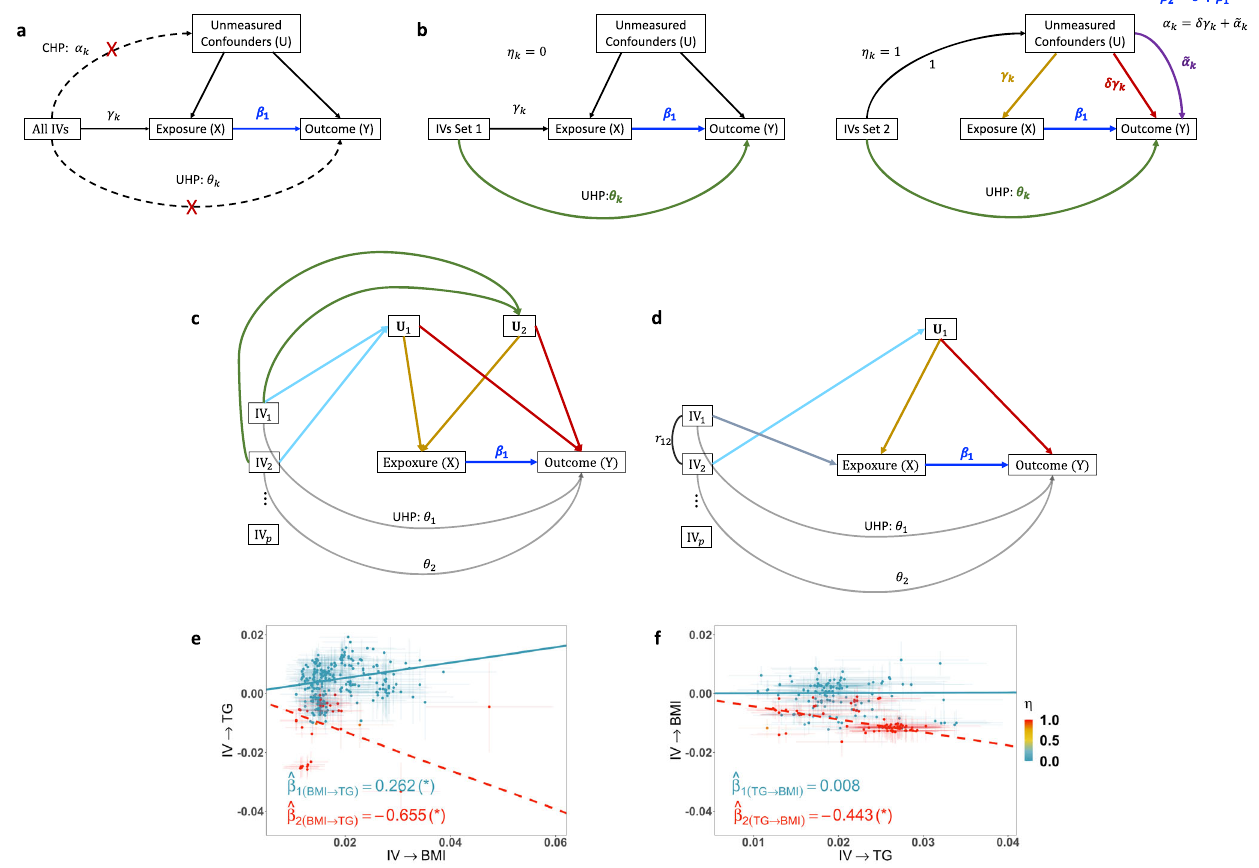
Fig. 1 | Causal diagrams of classic MR and MR-CUE models, with an illustrative example. a The causal diagram of classic MR models. Classic MR models assume that IVs affect outcome through only exposure. b An illustration of the MR-CUE model. MR-CUE decomposes IVs into two sets, those not affected by CHP (left, η η k =0) and those affected by CHP (right, k =1). MR-CUE allows all IVs to have potentialnon-zeroUHPeffect, θ k .In b rightpanel,weassumethattheIVaffectsthe exposureandconfounderproportionally,withasumofIV-to-exposureeffectof γ k . We rescale the IV-to-confounder effect to be 1 and the effect of confounders on exposure is then γ k (yellow line). The red line represents the decomposed and projectedconfounder-to-outcomeeffectandisalsoproportionaltoIV-strength, γ k . The IV-speci fi c perturbation of confounders may induce an IV-speci fi c bias, e α k , which has a mean of zero. c , d Illustrations of two scenarios when IV-speci fi c